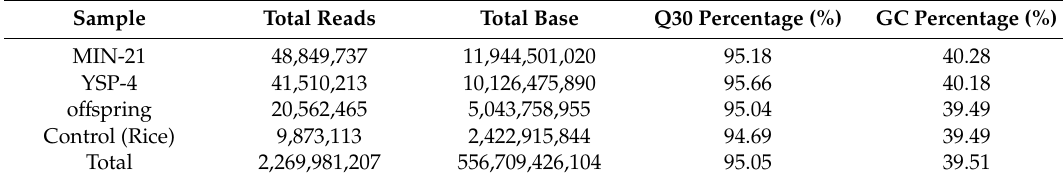
Table 1. Basic statistic of the SLAF-seq data in tetraploid potato.